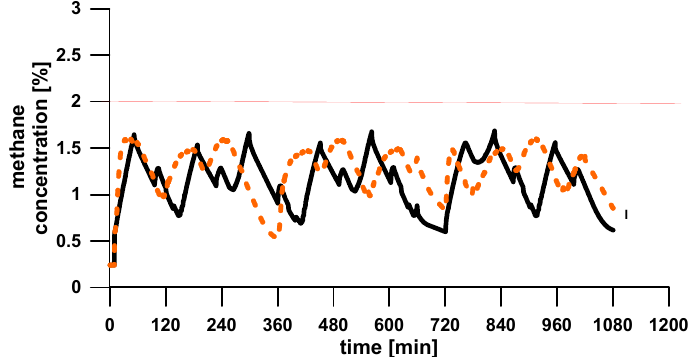
Figure 8. Changes in the methane concentration measured by a detector in the longwall at 115 m, where the intermittent orange line represents a case with speed control and the black line indicates a case without speed control. Energies 2020 , 13 , 5559